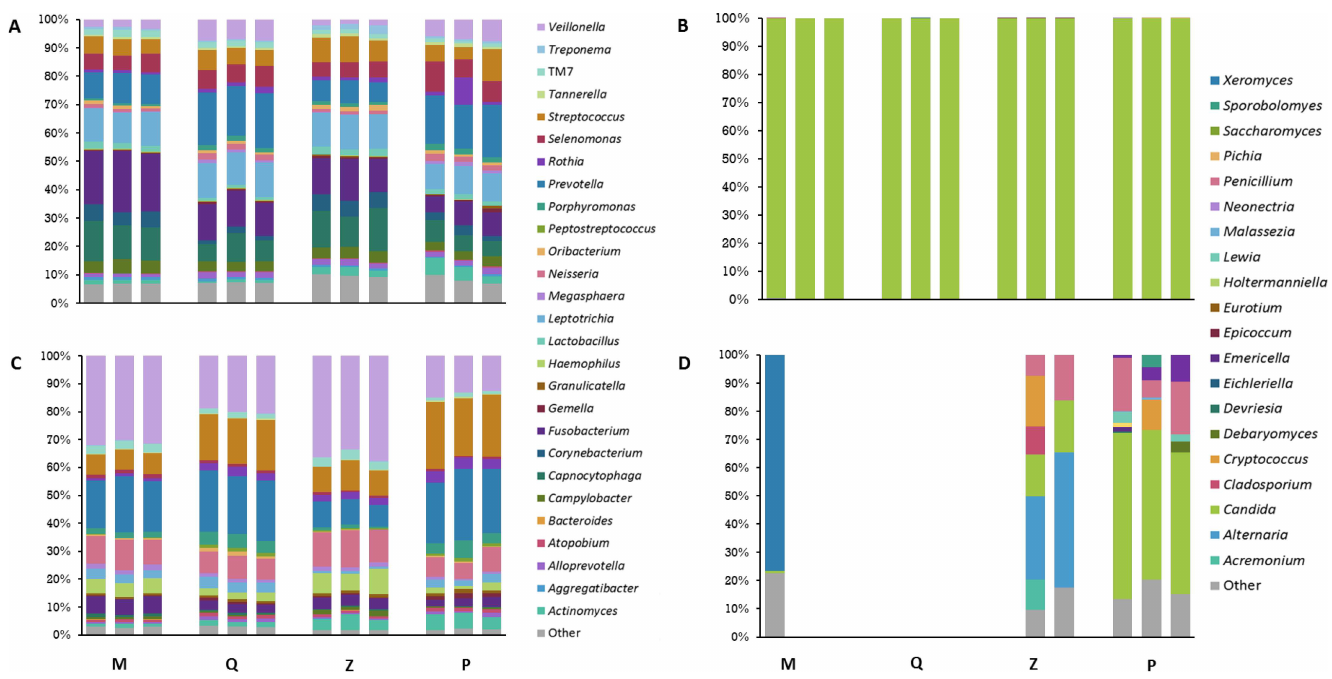
Fig 3. Taxa plots summarising the relative abundance of taxon-assigned OTUs identified in pooled homogenates for (A) bacterial genera in plaque; (B) fungal genera in plaque; (C) bacterial genera in saliva and (D) fungal genera in saliva. Each bar represents sequencing from three replicates, rarefied to 6000 sequencesper sample for bacterial generaand 959 for fungal genera, with replicates that did not meet these criteria excluded. M: MoBio PowerSoil ® DNA IsolationKit, Q: QIAamp ® DNA Mini Kit, Z: Zymo Bacterial/Fungal DNA Mini Prep TM , P: Phenol:chloroform-based DNA